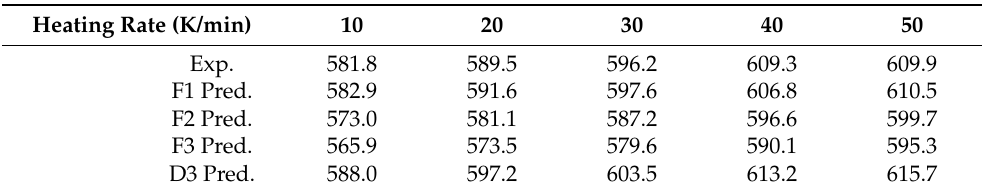
Table 1. The model-predicted vs. experimentally determined temperature (in units of K) at the peak conversion rate during pyrolysis of Artemisia stem under different heat rates. Heating Rate